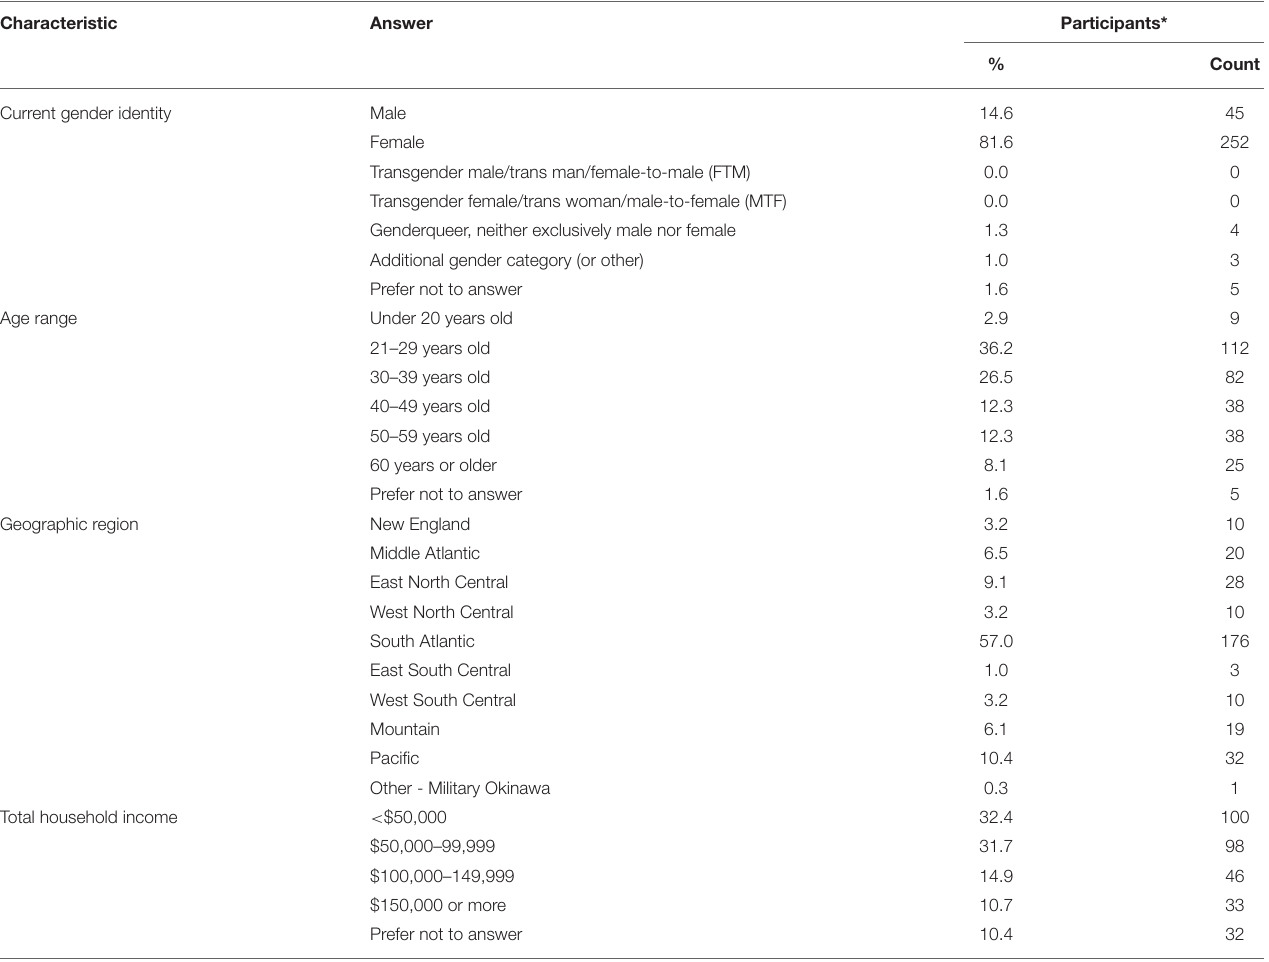
TABLE 2 | Demographic profile of